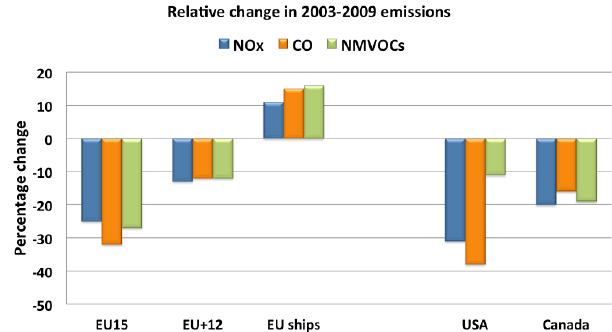
Figure 9. Relative change in NO x , CO and NMVOCs emissions from 2003 to 2009 (from Kuenen et al., 2014), per country group: EU15 includes the EU member states in 1995 as well as Norway and Switzerland, EU + 12 includes the 12 new member states, and EU ships refers to all European sea regions combined. US emissions are from the USA Environmental Protection Agency (EPA) and data for Canada are from Environment